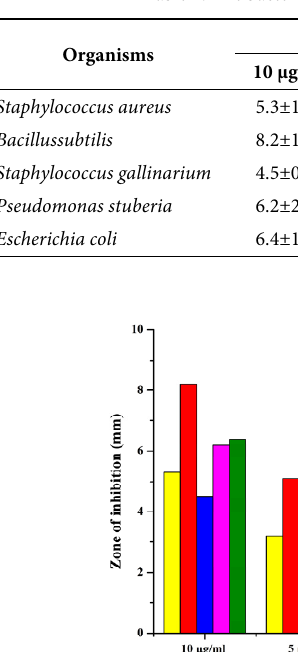
Table 4. Antibacterial activity of PSLASNPs sample